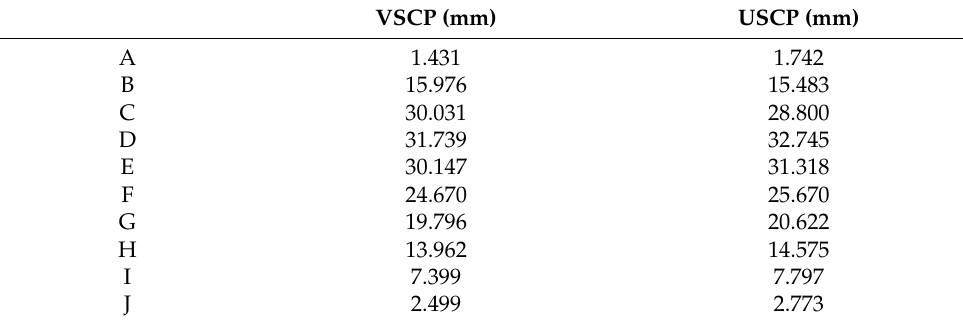
Table 10. Displacement contrast of 10 markers between VSCP and